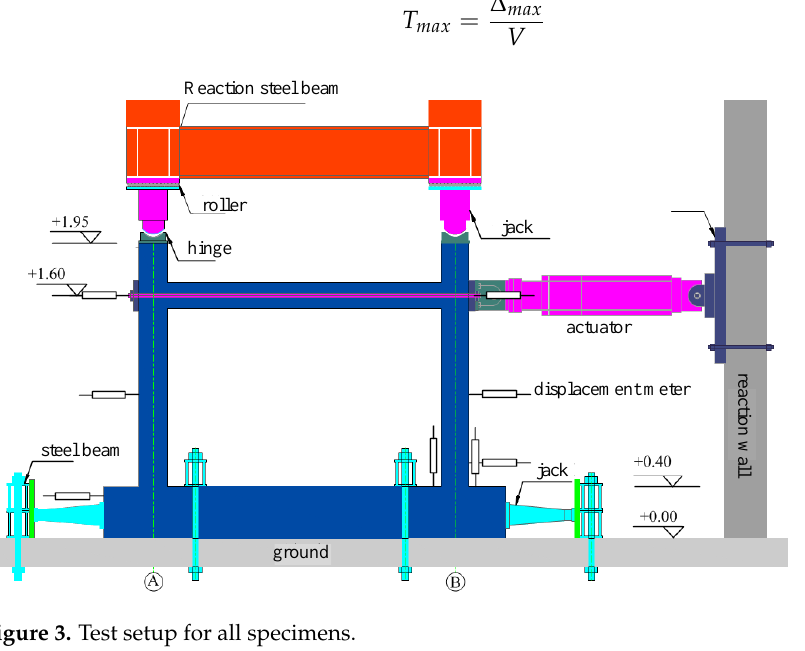
Figure 3. Test setup for all specimens.